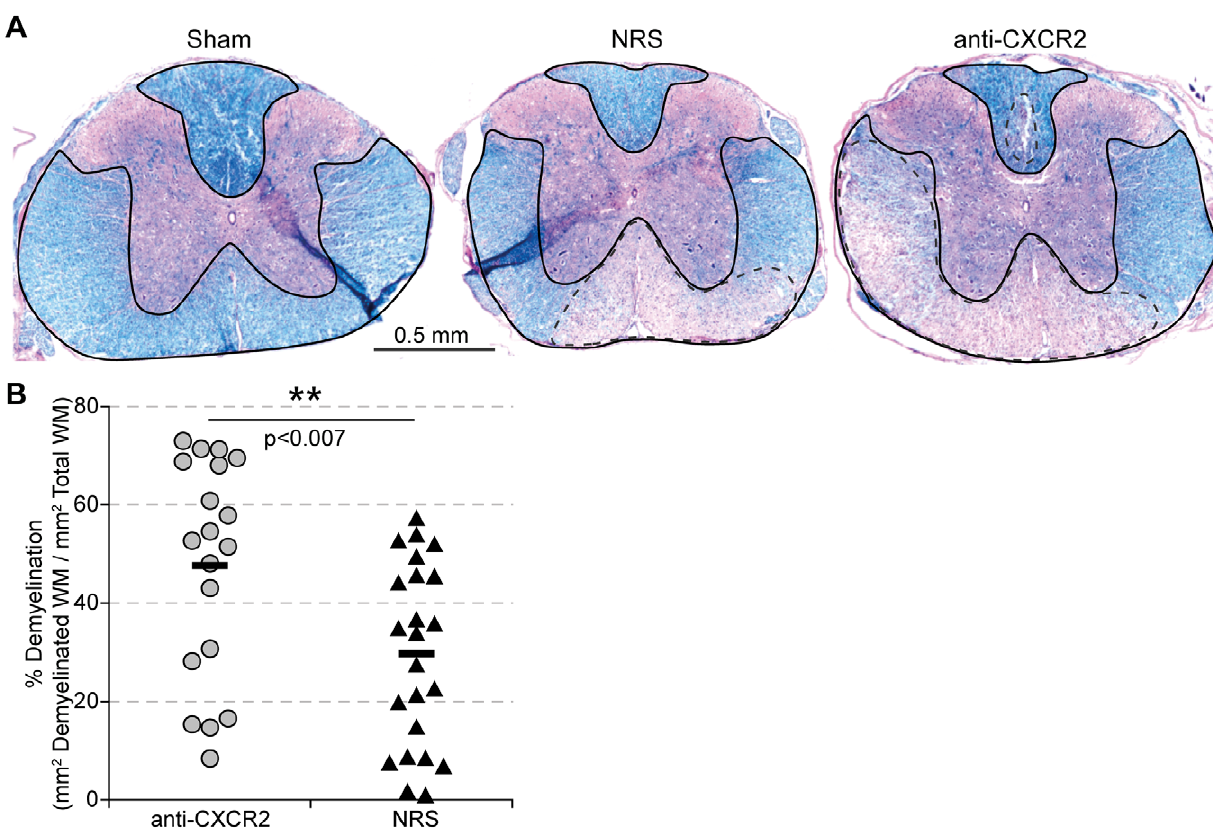
Figure 5. CXCR2 neutralization increases white matter demyelination. C57BL/6 mice were i.c. infected with 500 pfu JHMV and treated with neutralizing CXCR2 antiserum or control normal rabbit serum (NRS) i.p. from day 12 to 20. Spinal cords were removed at day 35 p.i. and coronal sections along the length of the spinal cord were stained with luxol fast blue to assess myelin integrity ( A ). Quantification of the total area of demyelination along the entire length of the spinal cord ( B ) revealed a significant increase in the percent demyelinated area of mice treated with CXCR2 antiserum (solid outline indicates total white matter, dashed outline indicates area of demyelinated white matter). Data is a summation of four independent experiments (anti-CXCR2 n=19, NRS n=23).